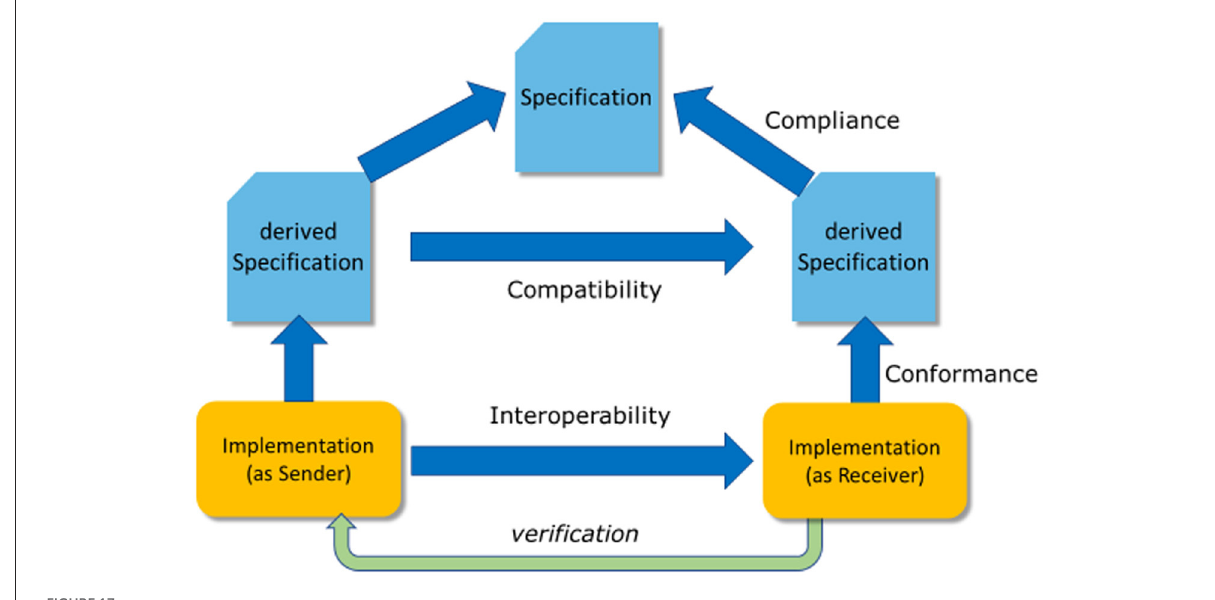
FIGURE17 Enhanced definition of